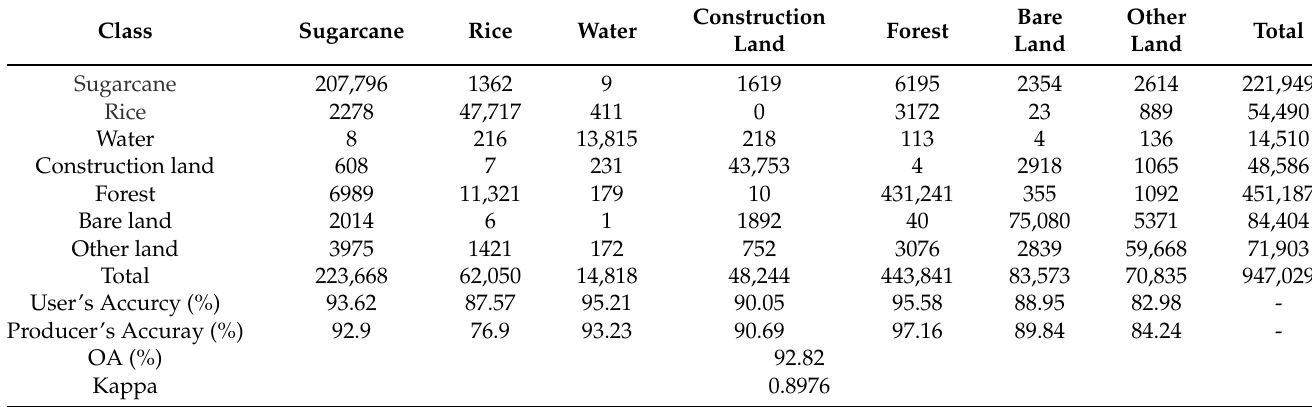
Table 7. Mixing matrix of the test set based on the algorithm proposed in this paper.